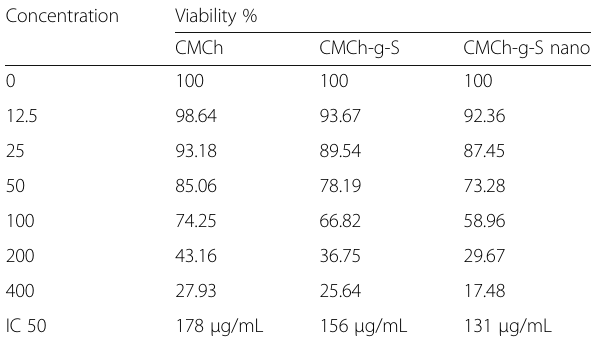
Table 4 Cytotoxicity effect of CMCh, CMCh-g-S and CMCh-g-S